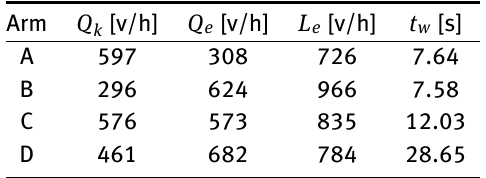
Table 6: Mean waiting time at the entrances. Source: authors.